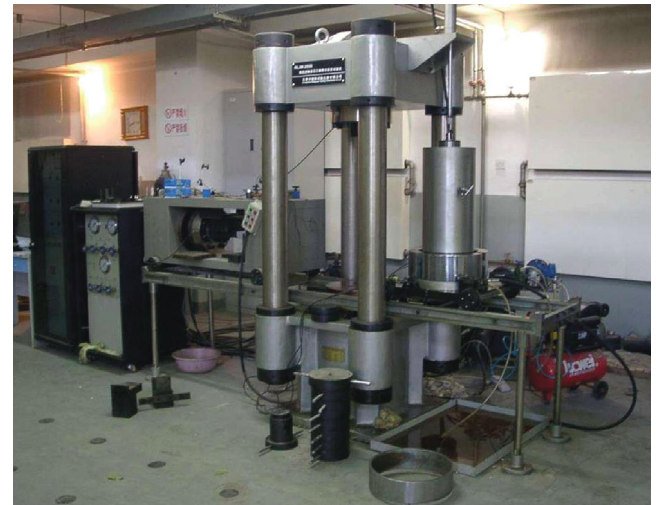
Figure 2: MTS815.2 test